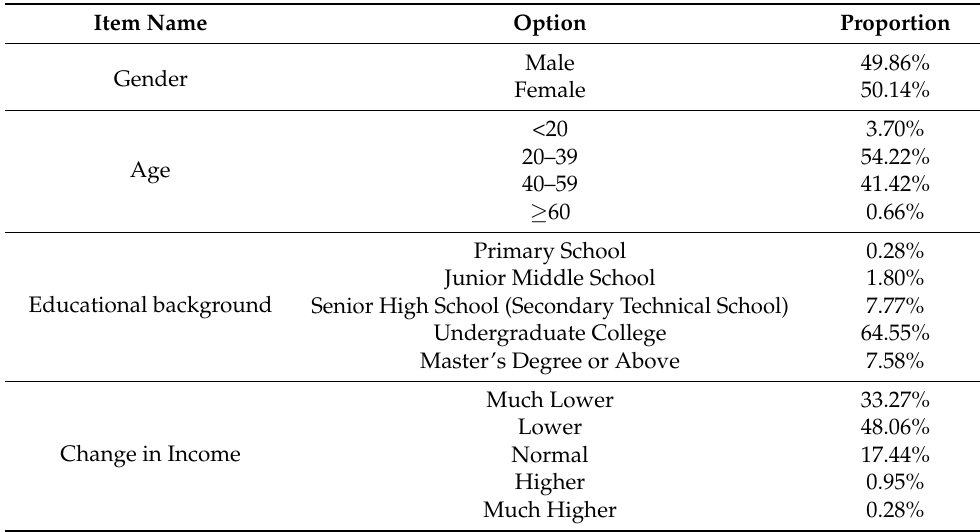
Table 2. Basic characteristics of Shanghai agricultural product